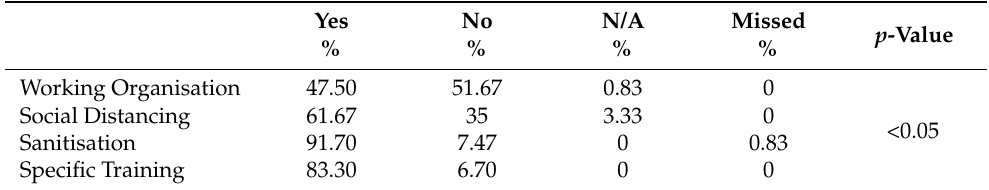
Table 3. Percentages of the whole sample’s